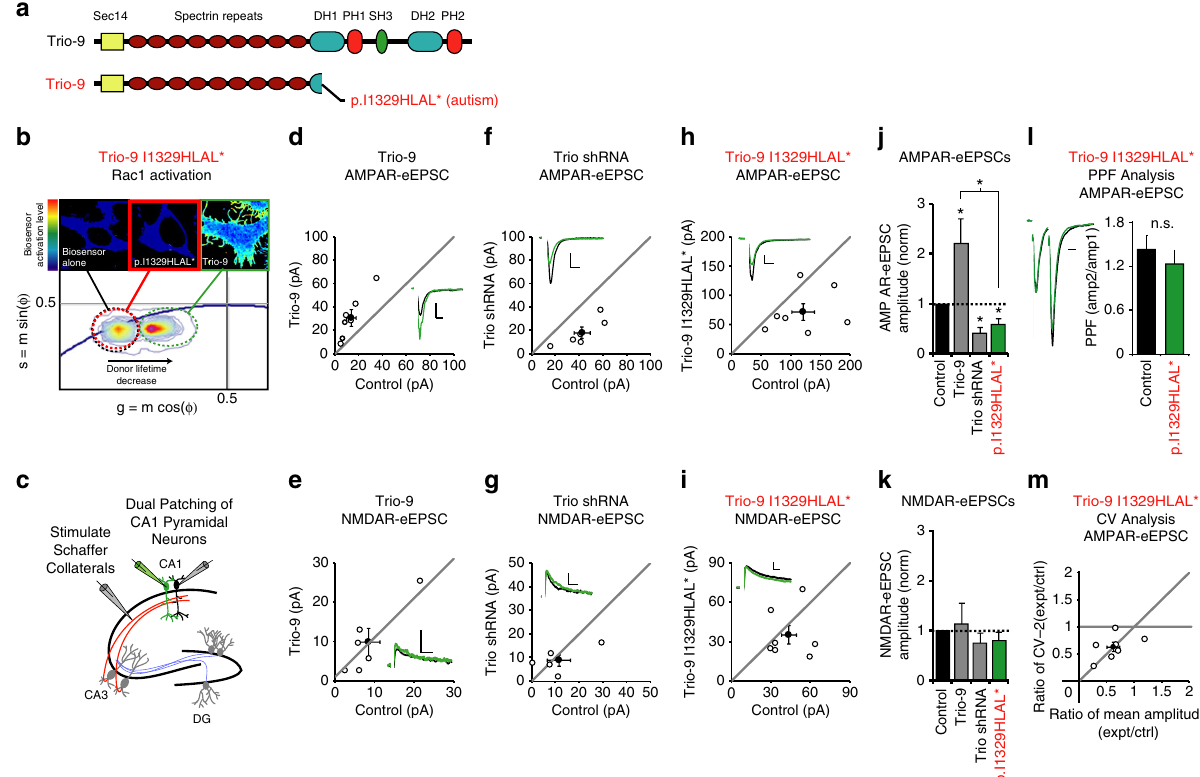
Fig. 4 Trio-9 p.I1329HLAL* expression reduces the strength of glutamatergic synapses. a Illustrations of Trio-9 and Trio-9 I1329HLAL*. b Trio-9 I1329HLAL* inhibits Trio-9 ’ s ability to activate Rac1. Representative FLIM color maps of HEK293 cells expressing the Rac1 biosensor, the biosensor and Trio-9 I1329HLAL* or the biosensor and Trio-9 are shown above. A cropped phasor plot for each condition is shown below. Dashed ovals identify the lifetime distribution for each condition. Complete phasor plots are shown in Supplementary Fig. 2. c Electrophysiological recording setup. d – i Scatterplots show eEPSC amplitudes for single pairs of control and transfected neurons ( open circles ). Filled circles show mean ± SEM. ( Insets ) Current traces from control ( black ) and transfected ( green ) neurons ( Scale bars : 20 ms for AMPA, 50 ms for NMDA, 20 pA). d Trio-9 expression increased AMPAR-eEPSC amplitude ( n = 7 pairs, * P < 0.05, Wilcoxon Signed Rank Test). e Trio-9 expression did not affect NMDAR-eEPSC amplitude ( n = 6 pairs, p > 0.05, Wilcoxon Signed Rank Test). f Trio shRNA expression reduced AMPAR-eEPSC amplitude ( n = 6 pairs, * P < 0.05, Wilcoxon Signed Rank Test). g Trio shRNA expression did not affect NMDAR-eEPSC amplitude ( n = 5 pairs, P > 0.05, Wilcoxon Signed Rank Test). h Trio-9 I1329HLAL* expression reduced AMPAR-eEPSC amplitude ( n = 7 pairs, * P < 0.05, Wilcoxon Signed Rank Test). i Trio-9 I1329HLAL* expression did not affect NMDAR-eEPSC amplitude ( n = 7 pairs, P > 0.05, Wilcoxon Signed Rank Test). j , k Average eEPSC amplitudes ( ± SEM) of neurons expressing Trio-9, Trio shRNA and Trio-9 I1329HLAL* normalized to their respective average control eEPSC amplitudes. A Wilcoxon Rank Sum Test was used to compare across independent conditions, (i.e., Trio-9 and Trio-9 I1329HLAL* in j , *P < 0.05). l Mean ± SEM paired-pulse facilitation (PPF) ratios for Trio-9 I1329HLAL* expressing and paired control neurons ( n = 6 pairs, P > 0.05, Student ’ s t-test). Peak 1-scaled current traces from control ( black ) and transfected ( green ) neurons ( Scale bar : 20